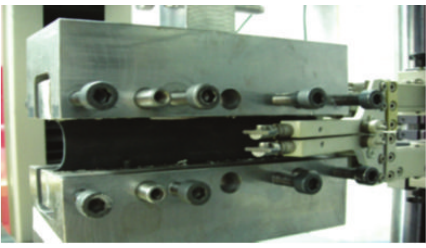
Figure 4: Planar tension material